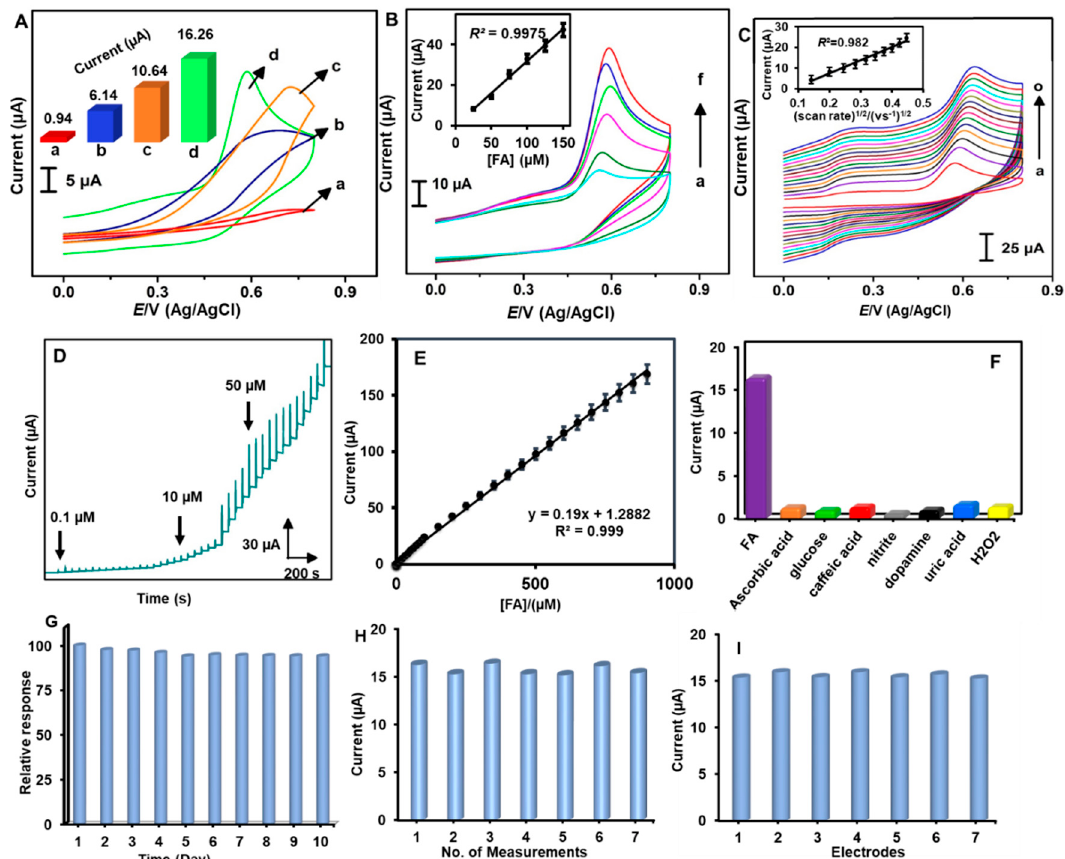
Figure 6. ( A ) CVs obtained at (a) unmodified GCE, (b) GCE/rGO/DA, (c) GCE/rGO/AuNPs, and (d) GCE/rGO/PDA/AuNPs towards 50 μ M FA suspended in phosphate buffer (pH 7.0). Inset: plot of current versus electrodes. ( B ) CVs of GCE/rGO/PDA/AuNPs towards varied concentrations of FA (a = 25, b = 50, c = 75, d = 100, e = 125, f = 150 μ M) suspended in phosphate buffer (pH 7.0), inset: anodic peak current/ μ A versus [FA]/ μ M. ( C ) CVs obtained at GCE/rGO/PDA/AuNPs in phosphate buffer (pH 7.0) containing 50 μ M FA at different scan rates (a to j: 0.02 to 0.2 V s − 1 ). Inset: FA reduction peak current versus (scan rate) 1/2 . ( D ) Amperometric responses of GCE/rGO/PDA/AuNPs towards series of different FA concentrations injected in phosphate buffer (pH 7.0) and ( E ) corresponding linear calibration plot, applied potential = 0.55 V. ( F ) Amperometric responses of GCE/rGO/PDA/AuNPs toward 50 μ M FA and 10-fold higher concentration of other species. ( G ) FA sensing performance of GCE/rGO/PDA/AuNPs for 10 continuous days (stability test), ( H ) 7 repeated measurements using a single electrode (repeatability test) and ( I ) reproducibility of 7 separate experiments using 7 independently fabricated electrodes. For stability, repeatability, and reproducibility, CVs were performed toward 50 μ M FA in a 0.1 M phosphate buffer (pH 7.0), while FA oxidation peak current was used to plot the bar diagram. Table 3. Comparison of folic acid analytical parameters between rGO/PDA/AuNPs film and reported modifiers.